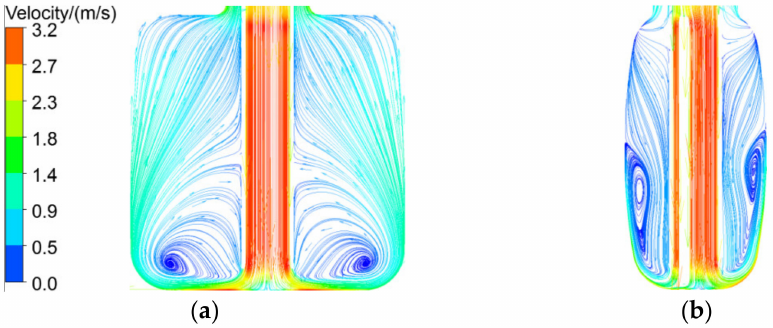
Figure 10. The streamline in the DPHM: ( a ) x = 0 mm; ( b ) y = 0